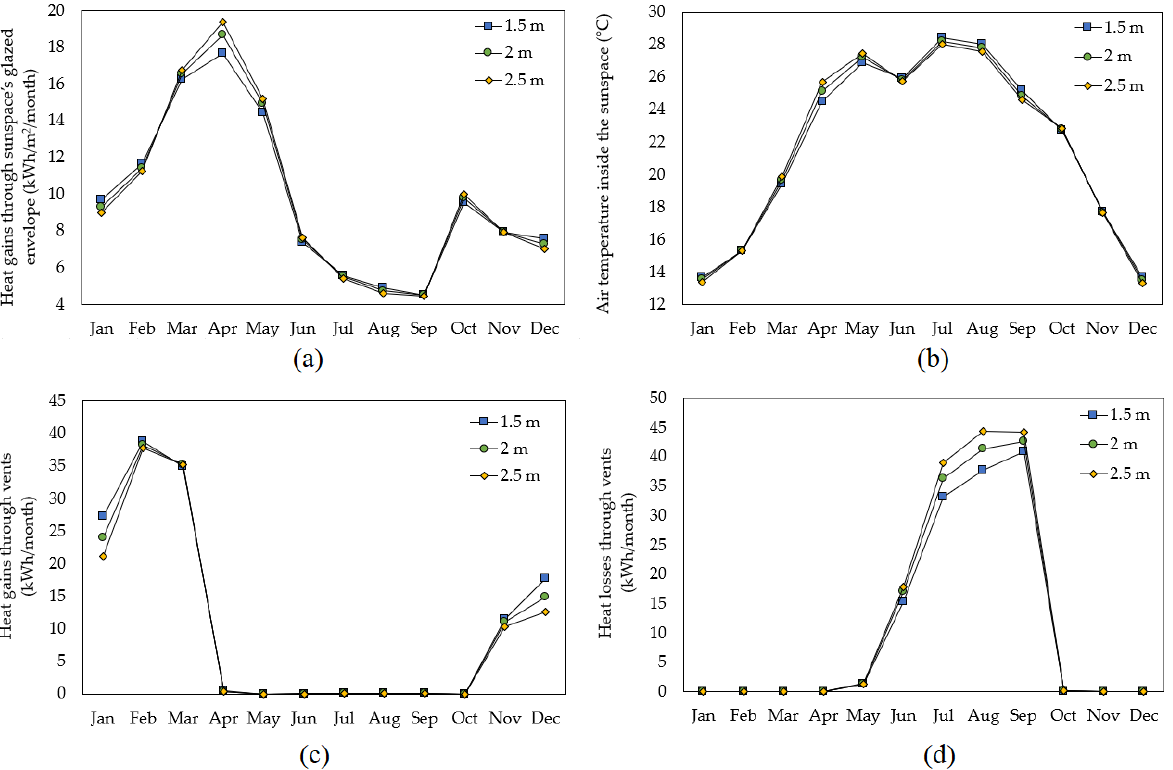
Figure 6. Depth analysis: ( a ) Monthly average heat gains through sun space’s envelope per unit of glazed surface; ( b ) monthly average air temperature inside the sun space; ( c ) monthly average living room heat gains through vents; ( d ) monthly average living room heat losses through vents.